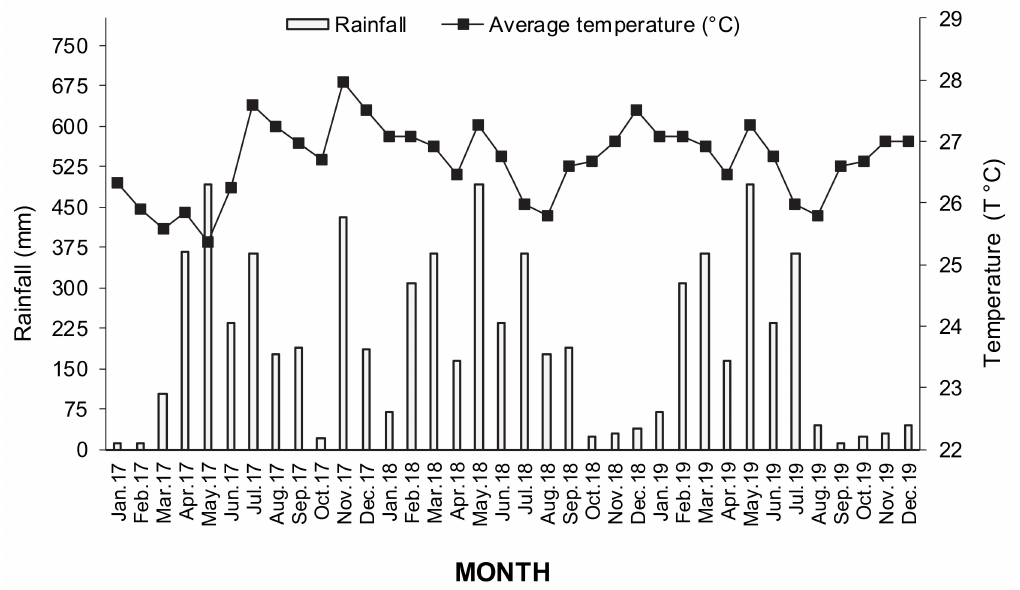
Figure 1. Month mean temperatures and rainfall from January 2017 through December 2019 in the experimental area in Orellana